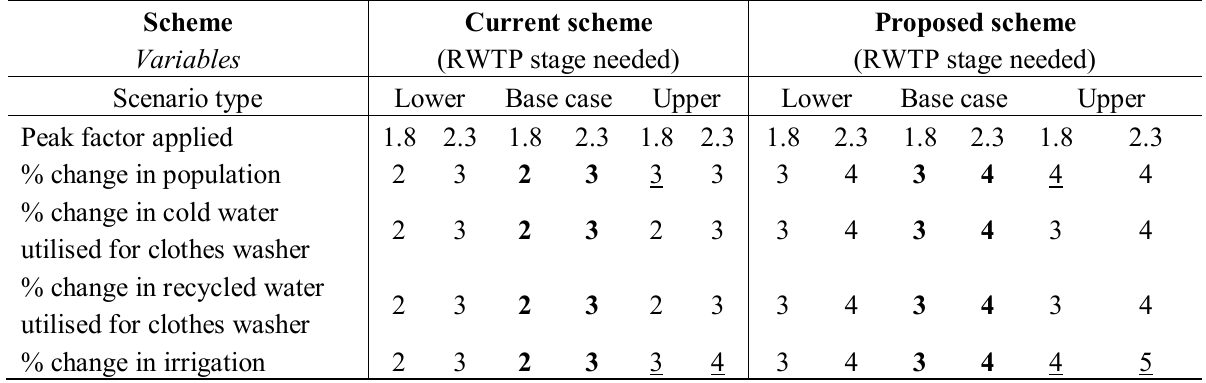
Table 2 . Forecasting results summary for current and proposed scheme